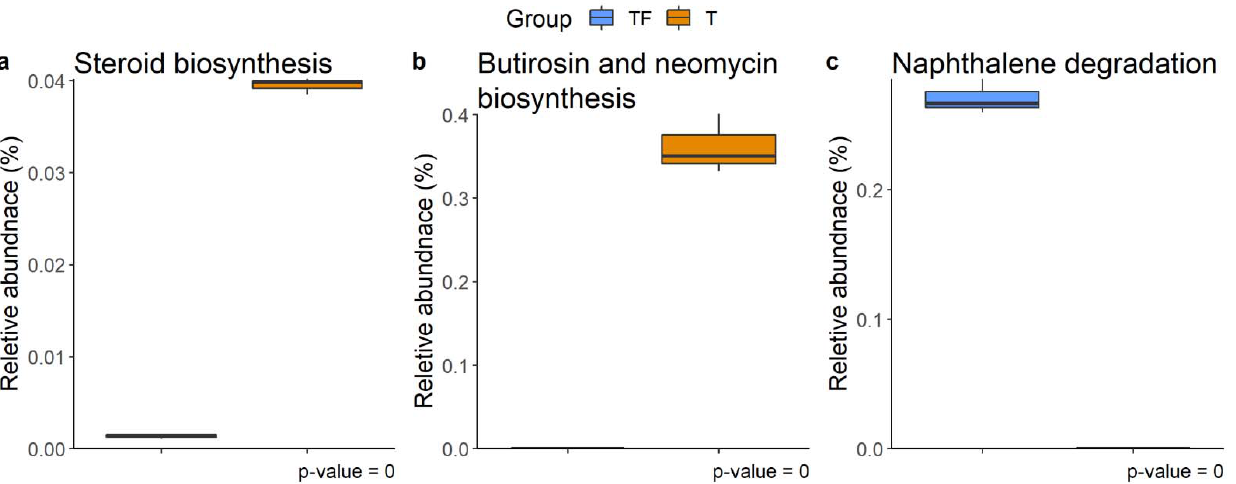
Figure 8. Different abundant KEGG metabolic pathways. ( a ) Steroid biosynthesis, ( b ) butirosin and neomycin biosynthesis, and ( c ) naphthalene degradation were found at week 4, week 7, and week 8, respectively. The relative abundance of function predicted by PICRUSt2 showed the different abundance of taxa predicted to have a specific function in T and TF groups. The BH adjusted p values from White’s non-parametric t -test are shown at the bottom of the box plots.